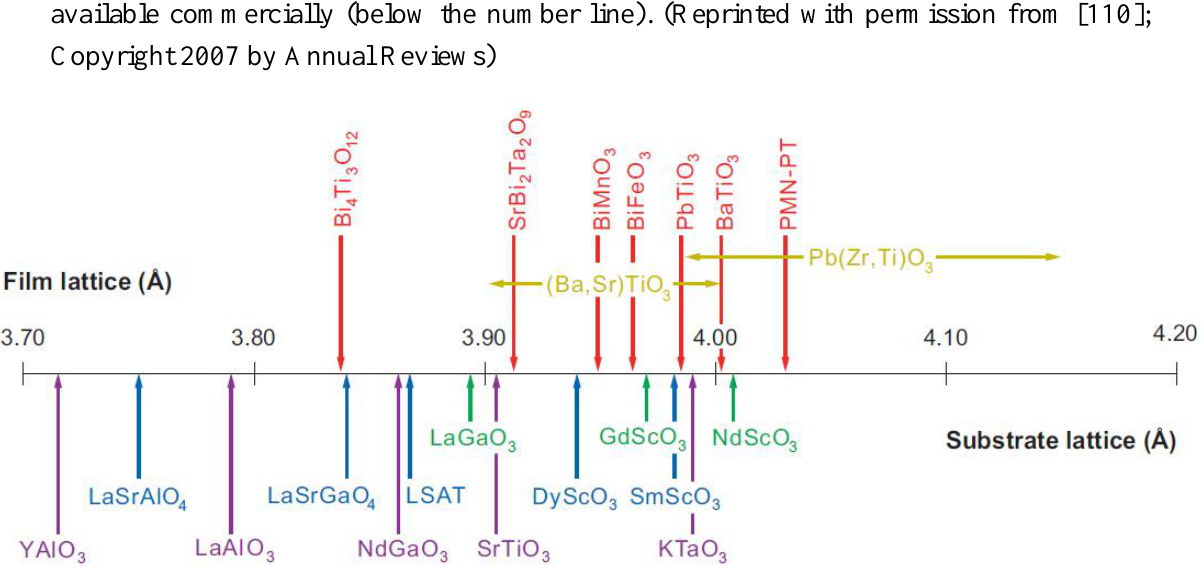
available commercially (below the number line). (Reprinted with permission from [110];